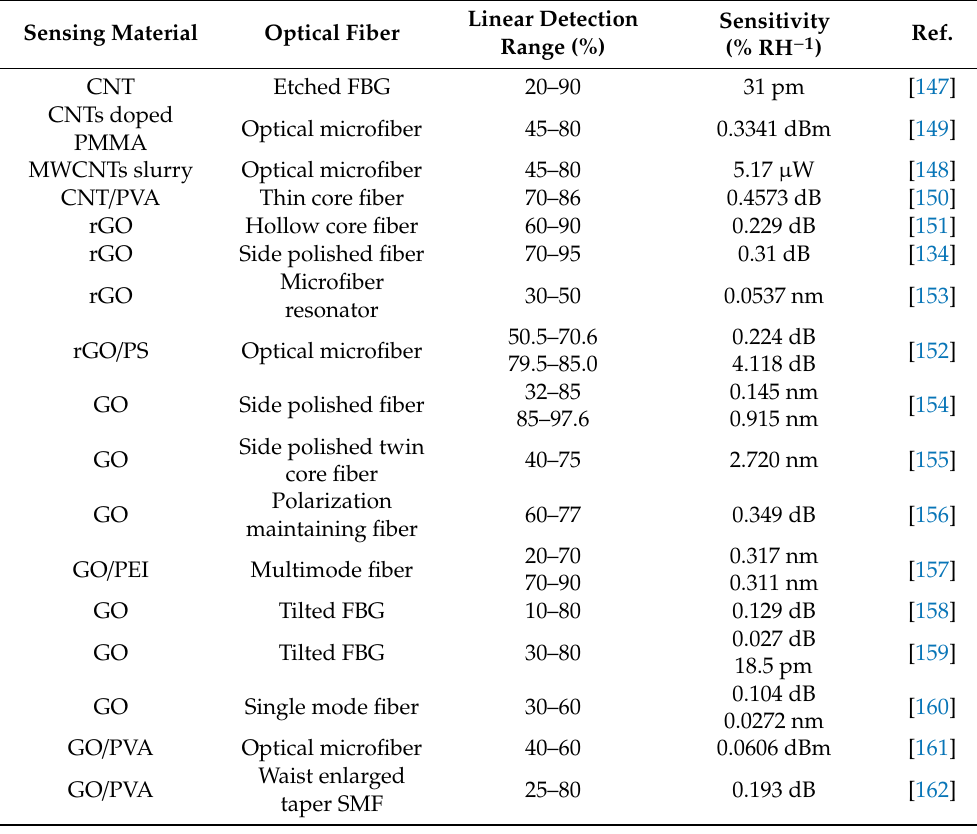
Table 3. Summary of carbon allotrope-based OFS for RH